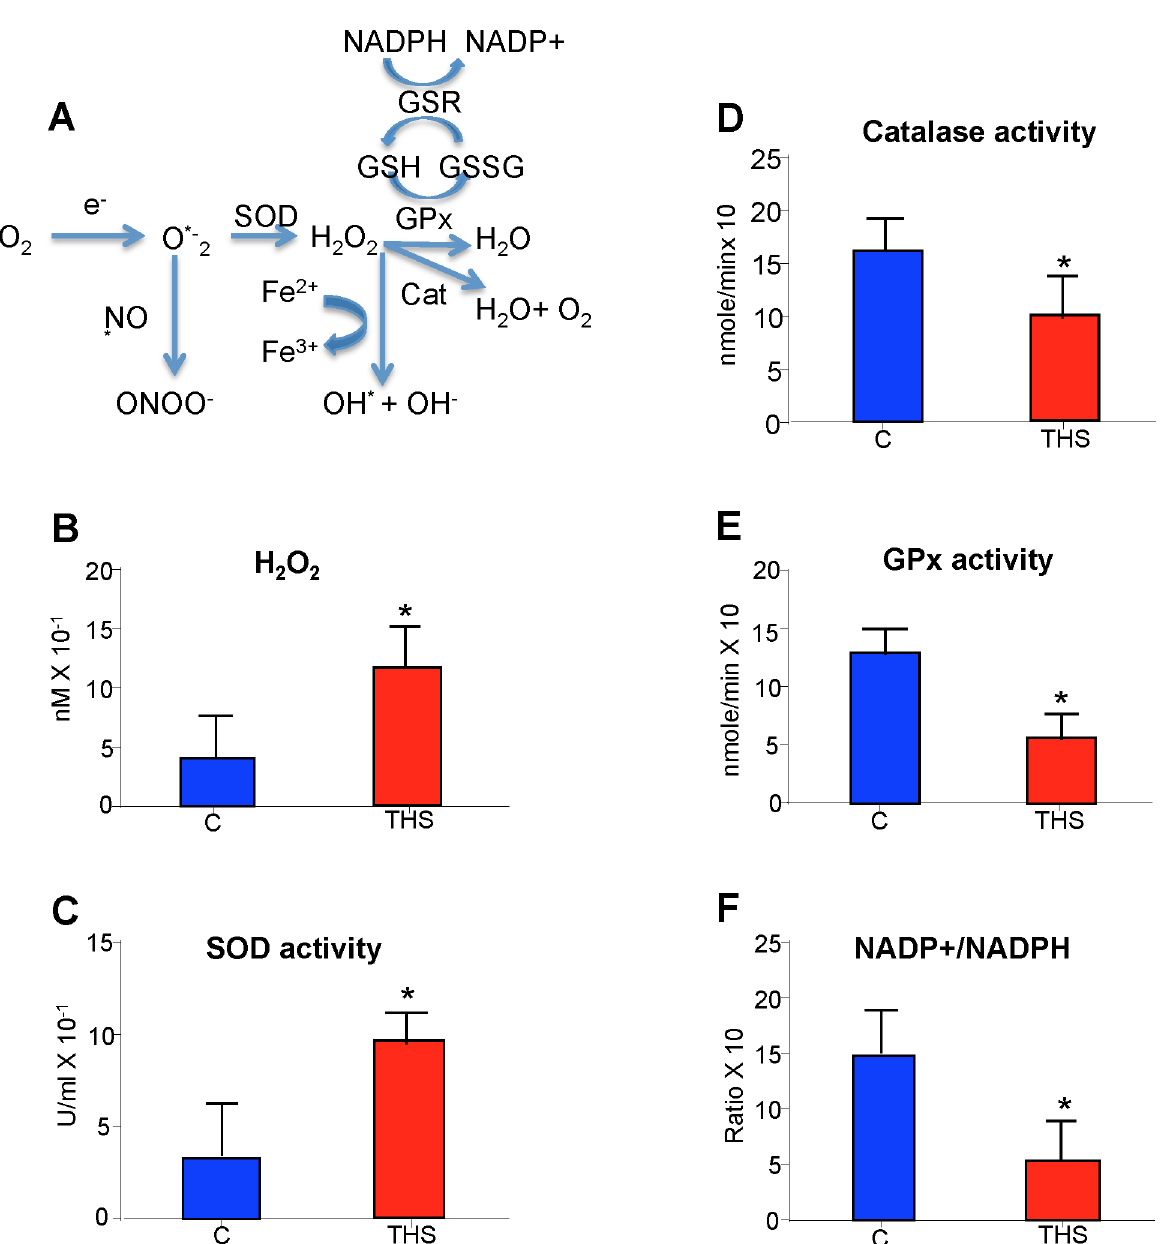
Fig 2. THS exposure results in oxidative stress in the skeletal muscle. (A) Schematic representation of oxidative stress response in cells. THS exposed mice have increased hydrogen peroxide (B) increased SOD enzymatic activity (C) decreased Catalse and GPx enzymatic activity (D-E) and the ratio of avaiblable NADP+ to NADPH is also decreased (F) . All data are Mean ± SD * = p < 0.05, ** = p < 0.01. n = 12. P values were adjusted for the number of times each test was run .